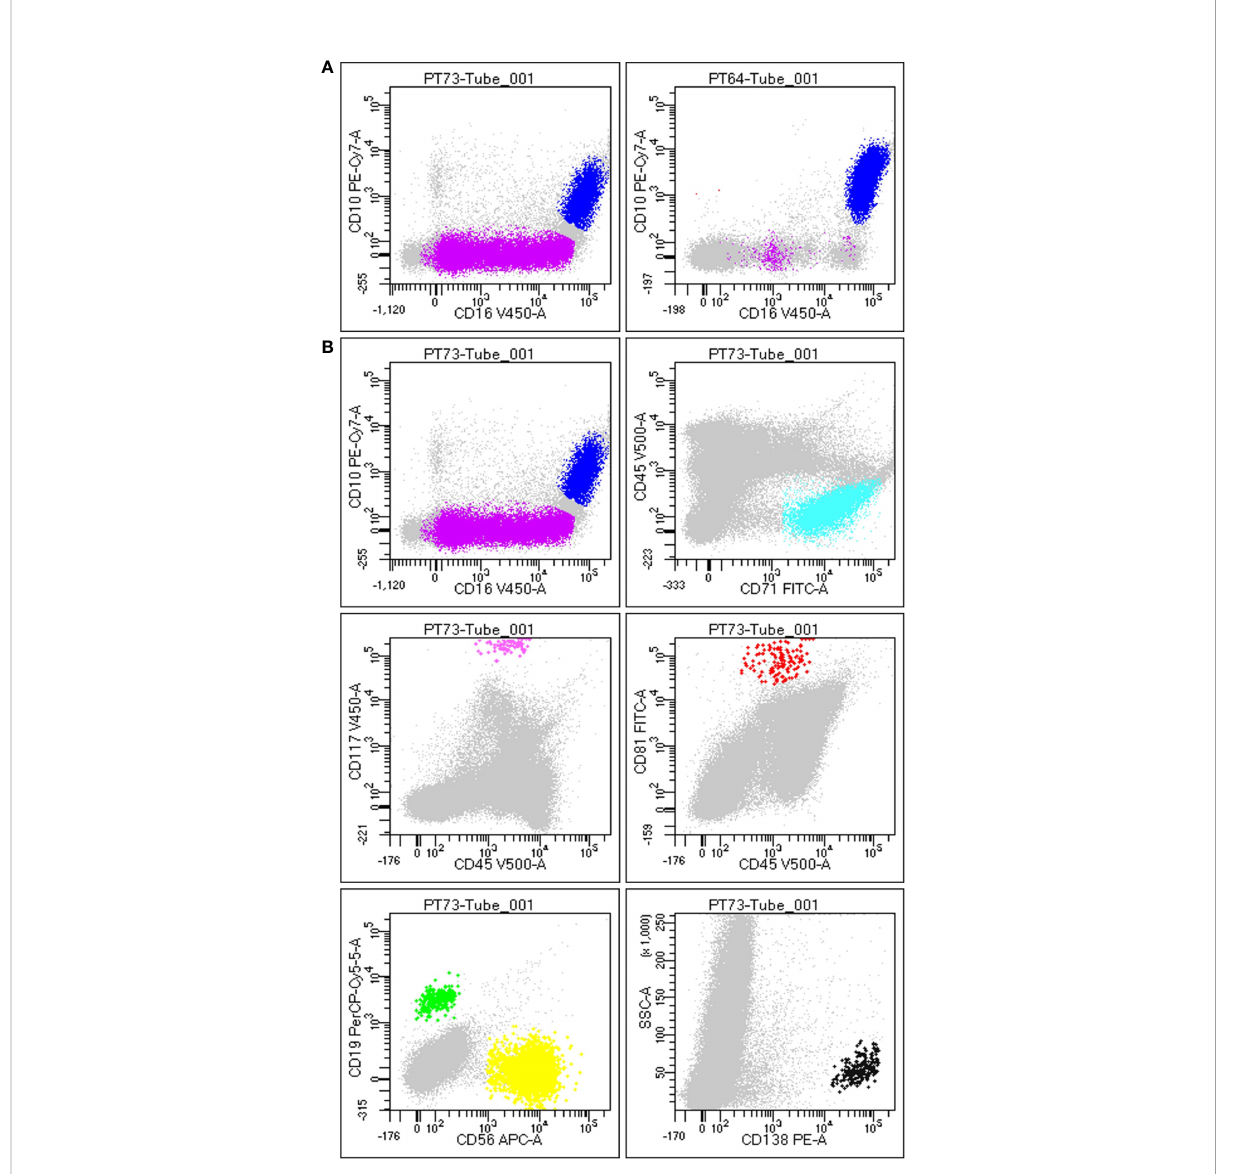
FIGURE 1 Gating strategy to de fi ne BM population. (A) Difference between a non-hemodiluted sample (left) and a hemodiluted sample (right), as shown by the presence of both immature (purple) and mature granulocytes (blue): the maturation line of granulocytes (including promyelocytes, myelocytes and metamyelocytes) is highlithed in purple and is highly present in nonHD samples (on the left), wherease it is almost absent in HD samples (on the right). (B) Each plot is the result of the different gating strategies used to de fi ne different populations, according to FSC/SSC and the speci fi c markers. In details, plot 1 displays immature (SSC++/FSC++; CD45dim/+/CD16low/CD10neg) and mature granulocytes (SSC++/FSC++; CD45dim/ +/CD10+/CD16+), plot 2 shows erythroblasts (SSClow/FSClow; CD45neg/CD71+), plot 3 displays mast cells (SSC++/FSC++; CD45dim/CD117hi), plot 4 exhibits hematogones (SSClow; CD45dim/CD10+/CD81hi), plot 5 shows B-cells (SSClow; CD45hi/CD19+/CD56neg) and T-cells (NK-like T- cells/NK; SSClow; CD45hi/CD19neg/CD56hi), and plot 6 displays plasma cells (SSClow/FSC+;